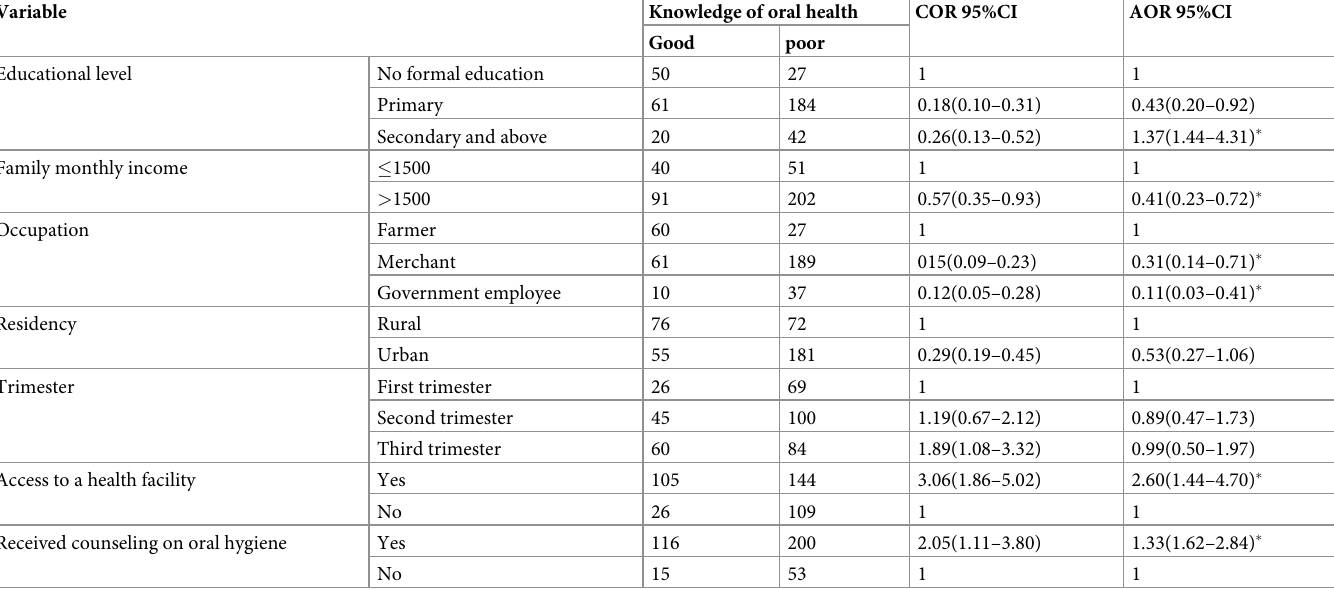
Table 2. Bivariate and multivariable logistic regression on knowledge of pregnant mothers attending antenatal care at South Omo Zone Hospitals, Southern Ethio- pia,